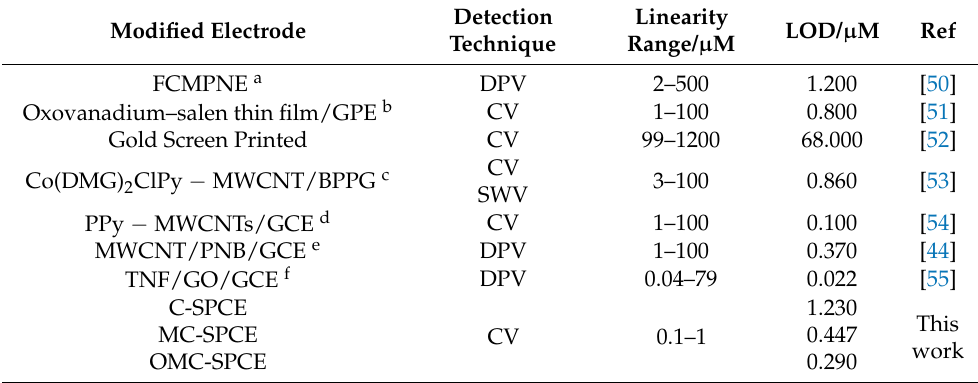
Table 5. Main modified sensors used to determine levodopa with different voltammetric techniques.